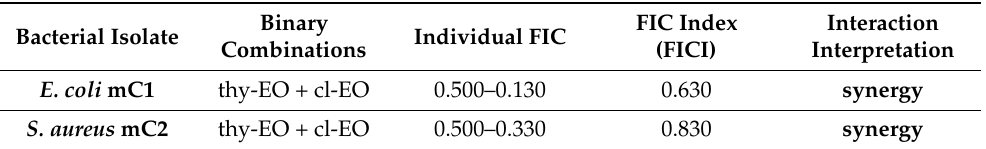
Table 3. Synergistic antibacterial effects of thyme and cloves essential oils in binary combination against Escherichia coli and Staphylococcus aureus food